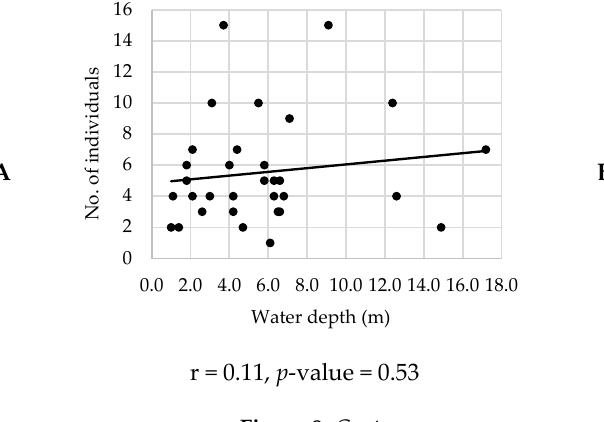
Figure 8. The number of individuals in a group of Irrawaddy dolphins displaying feeding behaviour versus abiotic factors (depth ( A ), turbidity ( B ), SST ( C ) and salinity ( D )). (Socializing) Pearson’s Correlation Coefficient at p <0.05